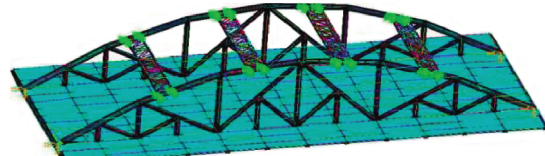
Figure 14: Finite element model of the bridge before reinforcement.